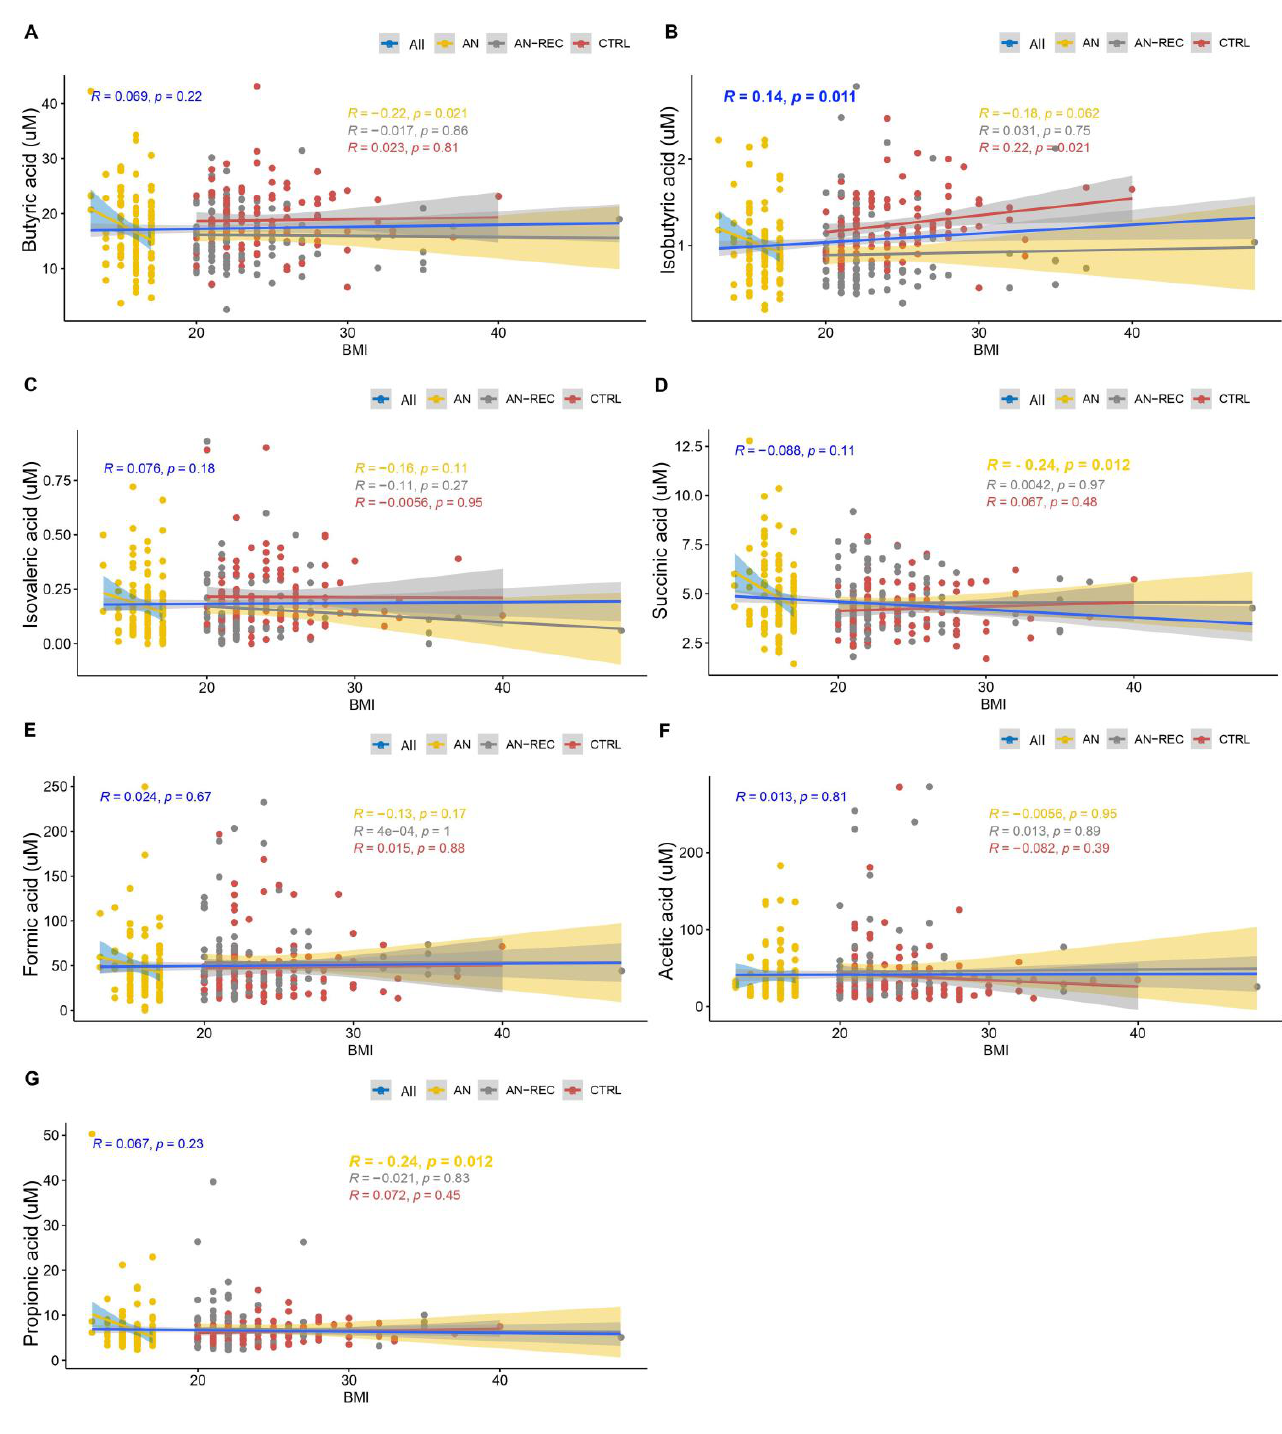
Figure 2. Graphs show correlations between SCFA plasma concentrations; butyric-( A ), isobutyric-( B ), isovaleric-( C ), succinic-( D ), formic-( E ), acetic-( F ) and propionic acid ( G ), and BMI. Lines correspond to medians. Blue lines correspond to the correlation over the whole BMI range, yellow ones to the correlation for the AN group, grey AN-REC, and red CTRL. The shaded line around each linear fit line represents a 95% confidence interval. p < 0.017 is considered